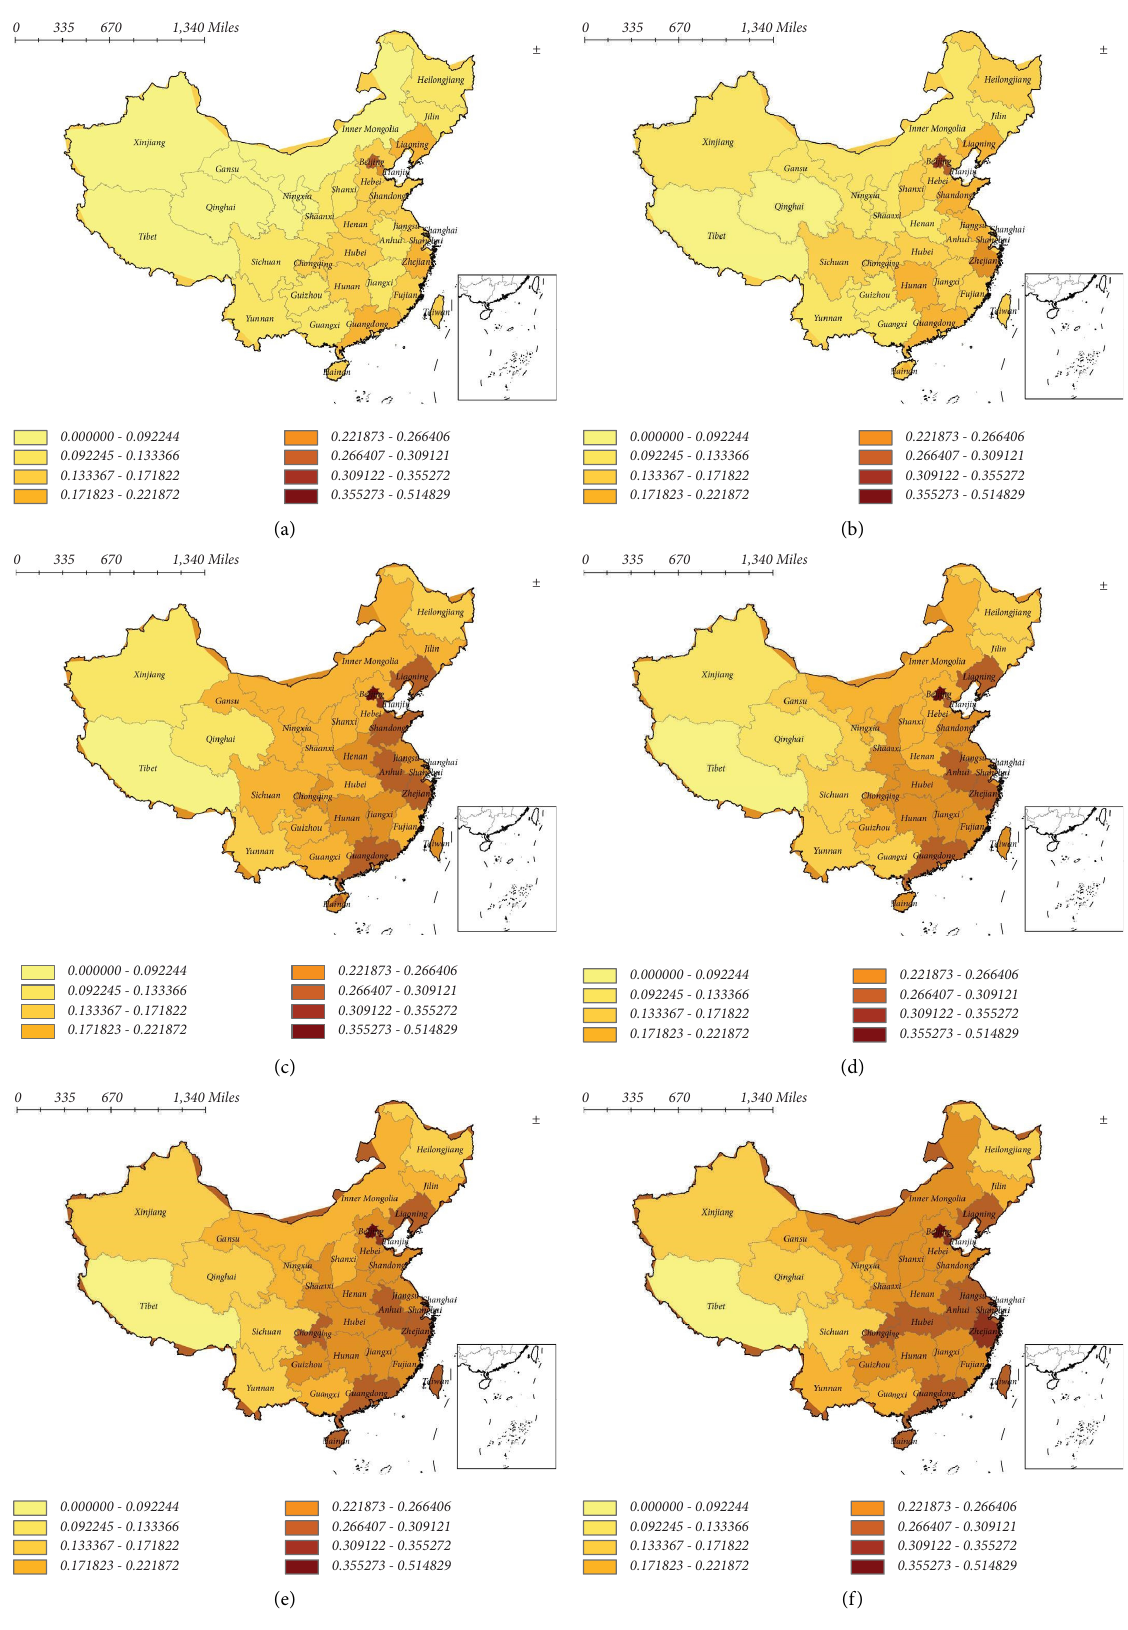
Figure 4: Distribution of the evaluation index of the level of high-quality development of comprehensive transportation by province in diferent years. (a) 2000. (b) 2005. (c) 2010. (d) 2015. (e) 2017. (f)